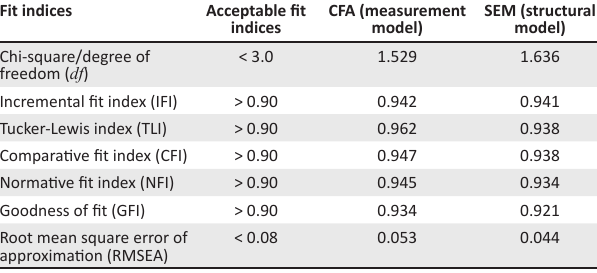
TABLE 5: General model fit